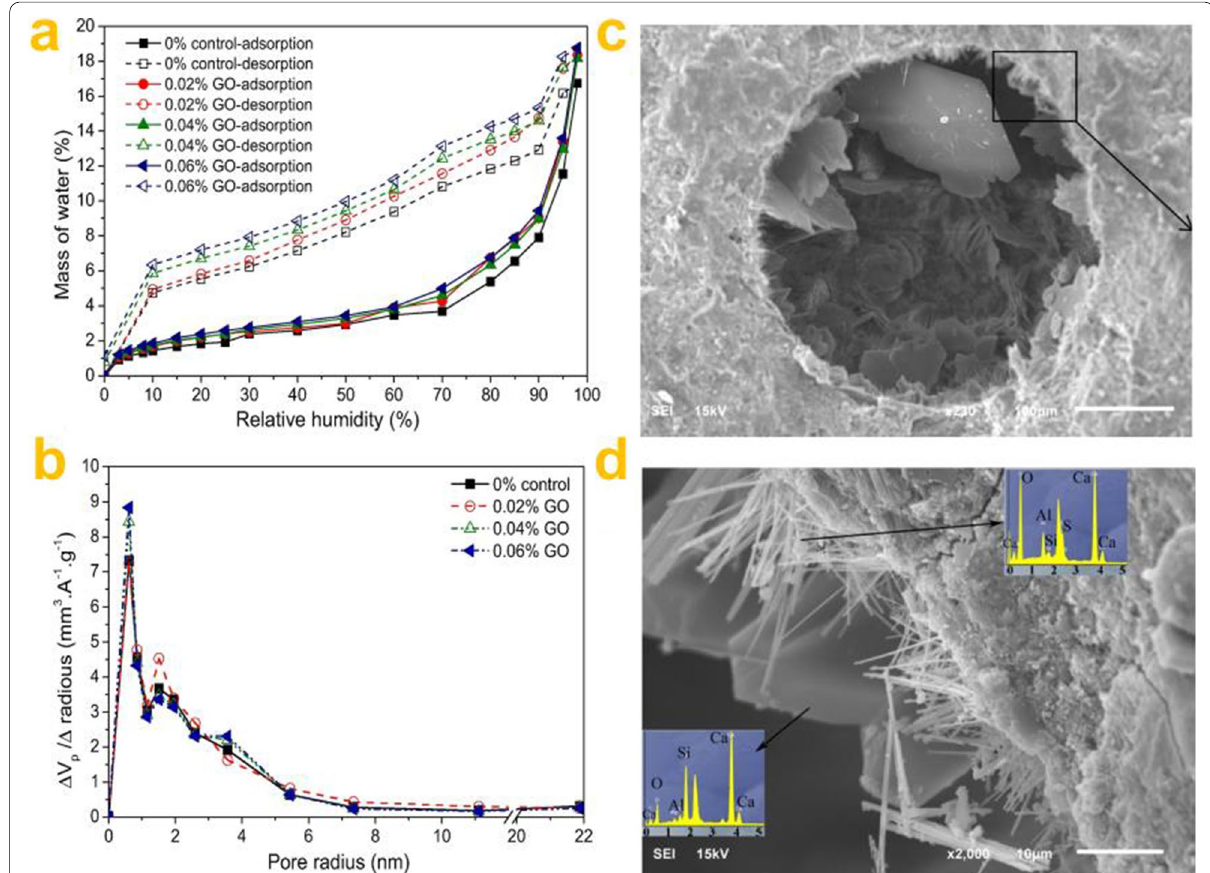
Fig. 9 Properties of cement composites with the addition of GO: a mass loss b pore size distribution c SEM images of mixture with 0.06 wt% GO, and d magnification of black rectangle indicating the surface growth nature of flake structures and AFt [153]. (Copyright 2019